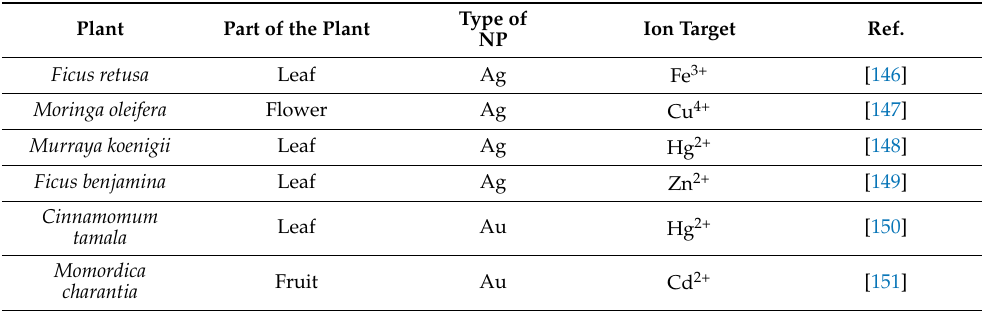
Table 7. Plant-based gold and silver nanoparticles as colorimetric